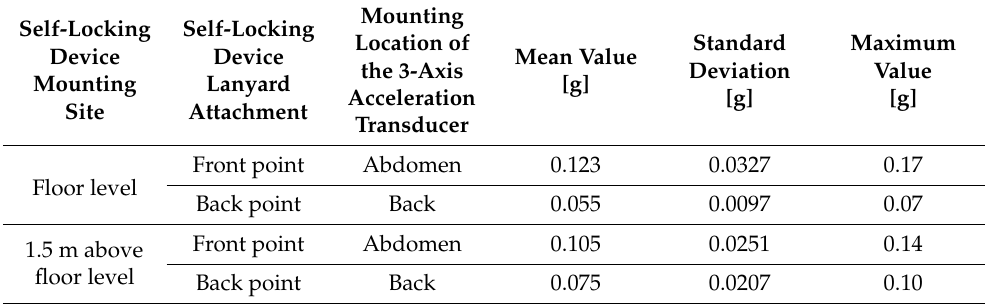
Table 2. Results of acceleration measurements when testing the tipping behavior of the manikin.